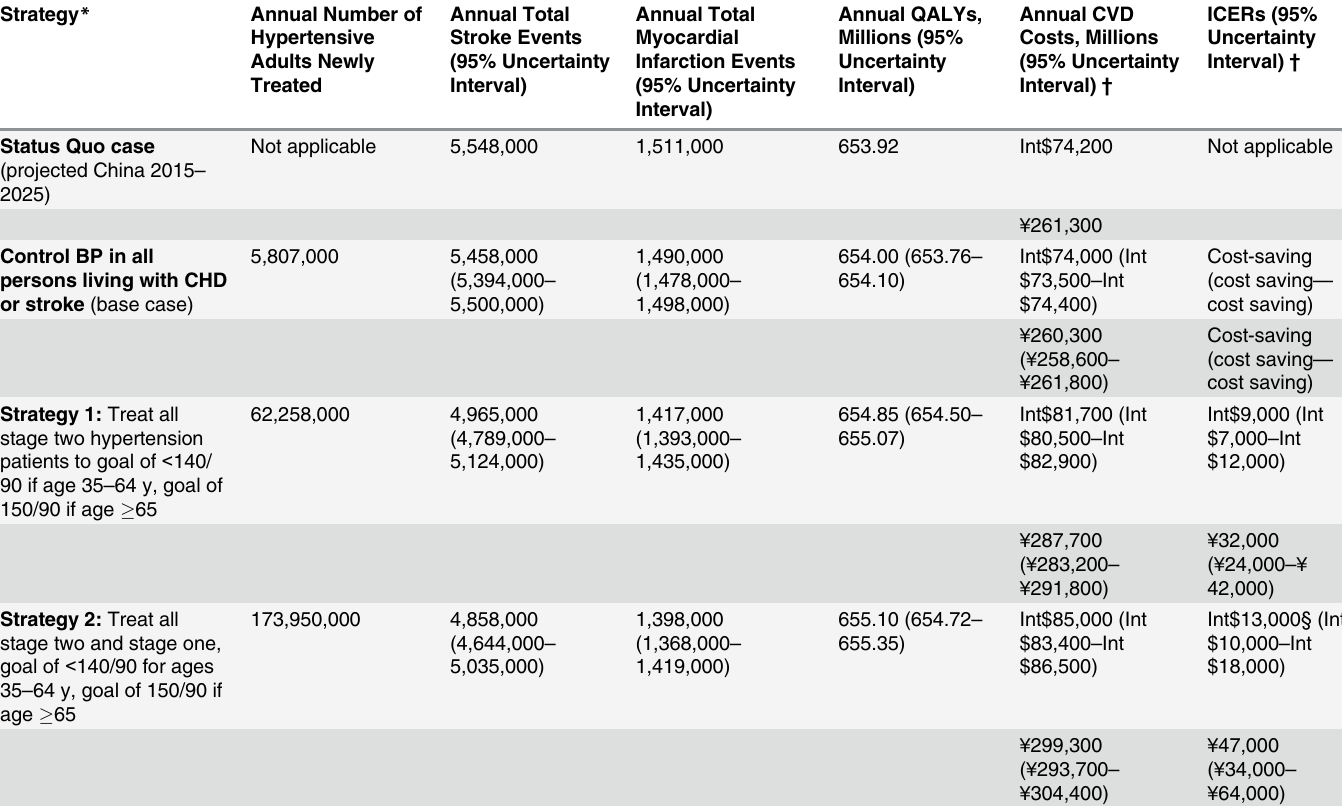
Table 2. Effectiveness and cost-effectiveness of implementing different BP control guidelines in untreated Chinese adults aged 35 – 84 y with hypertension, averaged from the projections for 2015 – 2025, the CVD Policy Model-China. Each successive strategy is compared with the prior strat- egy. Results are in 2015 international dollars and 2015 Chinese RMB. All results reported as cost-saving describe strategies projected to be less costly and more effective than the prior strategy. Ninety-five percent uncertainty intervals were calculated from the results of 1,000 probabilistic